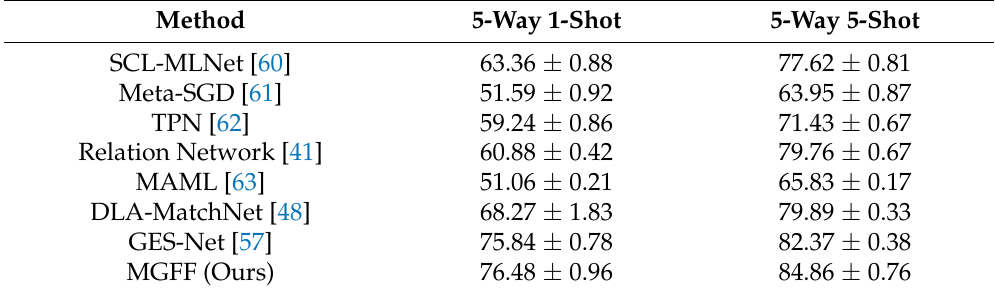
Table 4. Classification accuracies of 5-way 1-shot and 5-way 5-shot on the WHU-RS19